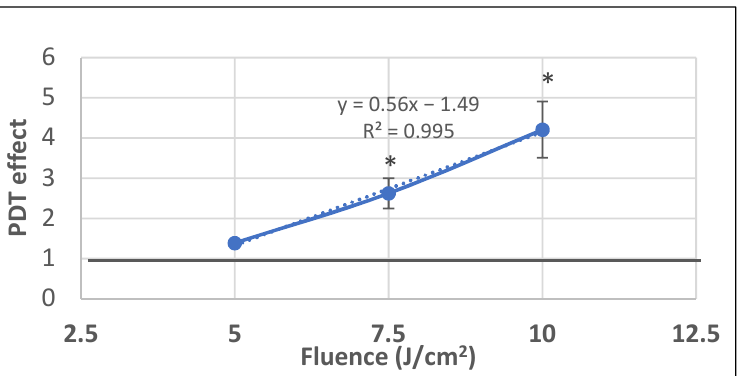
Figure 9. The dependence of LDH release by HT29 tumor cells exposed to milder PDT conditions on the fluence of the activating light (5–7.5–10 J/cm 2 ) that was delivered at a lower fluence rate of 10 mW/cm 2 . Results are presented as PDT effect (mean ± SEM) in triplicate samples. PDT effect was calculated as OD in samples subjected to PDT divided by the mean OD value in controls. Comparison between samples was performed using Student’s t -test considering unequal variances: * p < 0.05.